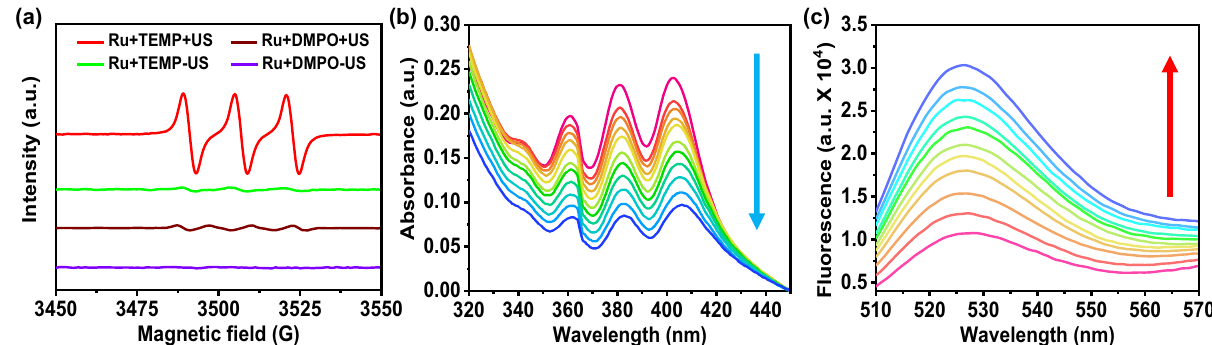
Fig. 1 Sonosensitizer performance of [Ru(bpy) 3 ] 2 + . a ESR spectra demonstrating 1 O 2 generation of [Ru(bpy) 3 ] 2 + under US irradiation (0.3 W cm − 2 , 3 MHz, 1 h). The TEMP and DMPO were used as 1 O 2 and • OH trapping agents, respectively. b Time-dependent oxidation of DPA indicating 1 O 2 generation by [Ru(bpy) 3 ] 2 + under US irradiation (0.3 W cm − 2 , 3 MHz). c Time-dependent 1 O 2 generation of [Ru(bpy) 3 ] 2 + detected by fl uorescence intensity of SOSG under US irradiation (0.3 W cm − 2 , 3 MHz). The colored lines represent spectra recorded every 10 min for 100 min in ( a ) and ( c ). Ru: [Ru(bpy) 3 ] 2 +